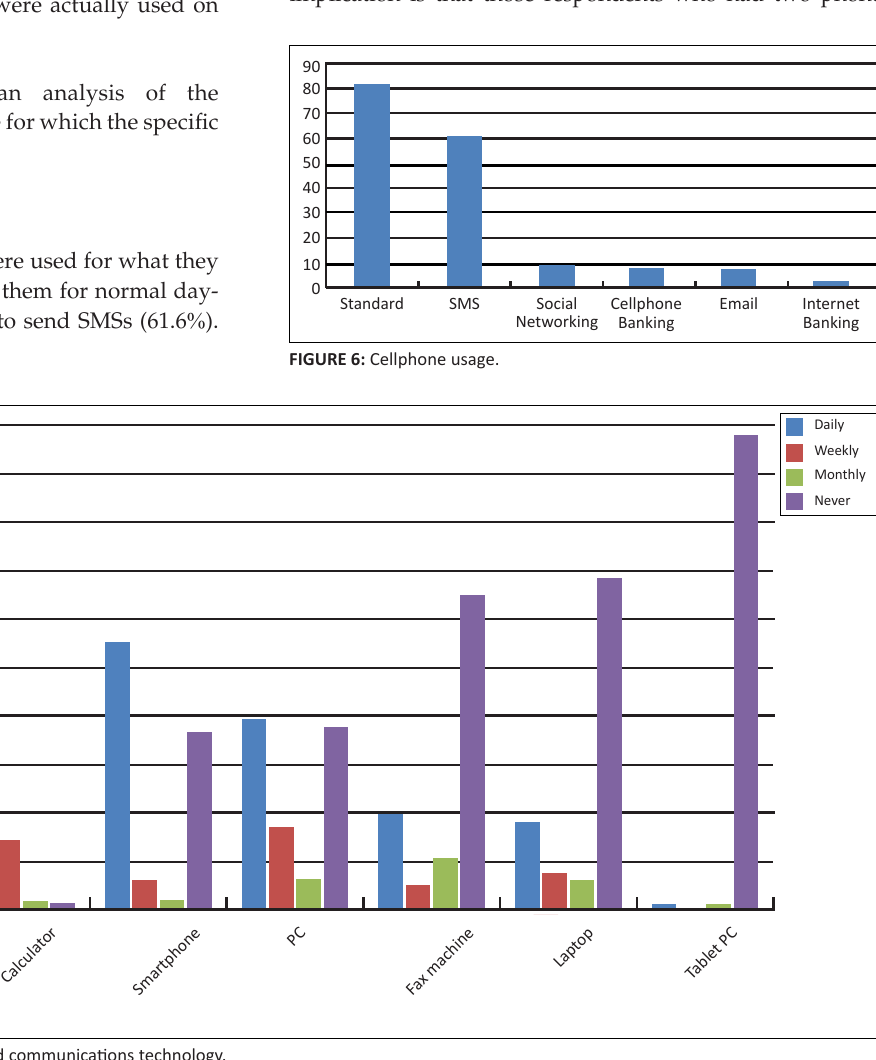
FIGURE 5: Frequency and usage of information and communications